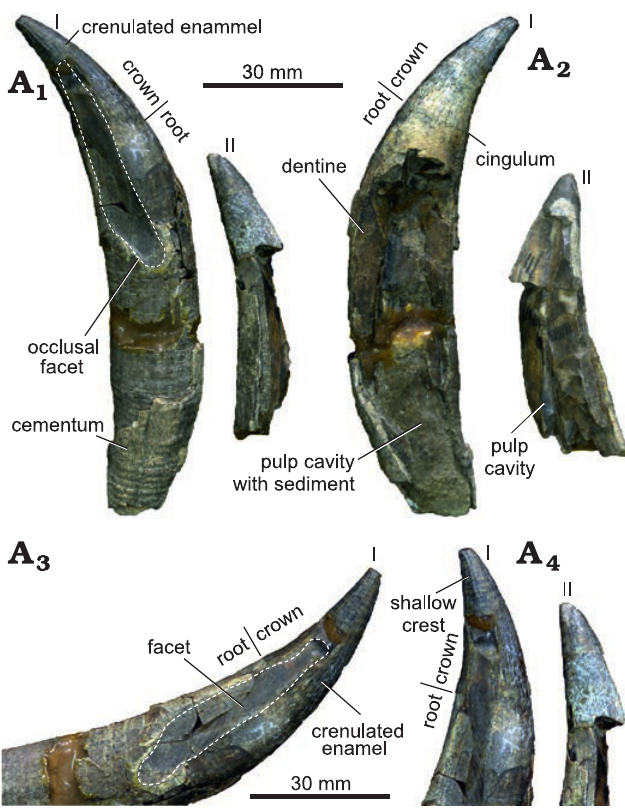
Fig. 2. Teeth of a sperm whale Physeteroidea indet. previously described as “ Preaulophyseter gualichensis ” Caviglia and Jorge, 1980, MLP 76-IX- 5-1, from the Miocene of Gran Bajo del Gualicho Formation, Patagonia, Argentina; in labial (A 1 ) and lingual (A 2 ) views, and detailed view of the crown (A 3 ) and enamel (A 4 ). I and II refer to the two fragmentary teeth of the MLP 76-IX-5-1 (the best and worst preserved tooth,